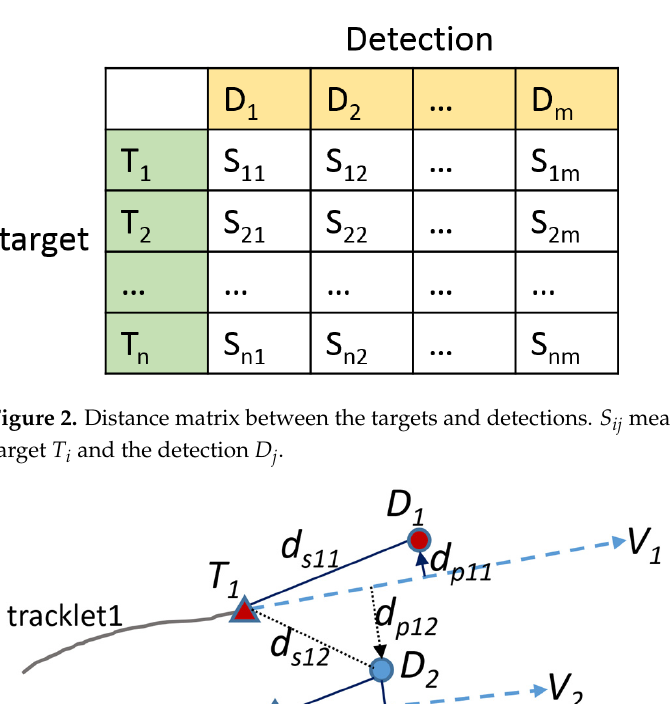
target (cid:48) s velocity, which is a vector defined by the thick, dotted lines depicted in Figure 3. Figure 2. Distance matrix between the targets and detections. S ij measures the distance between the The velocity of the target T 1 and T 2 are represented by V 1 and V 2 , respectively. target T i and the detection D j .